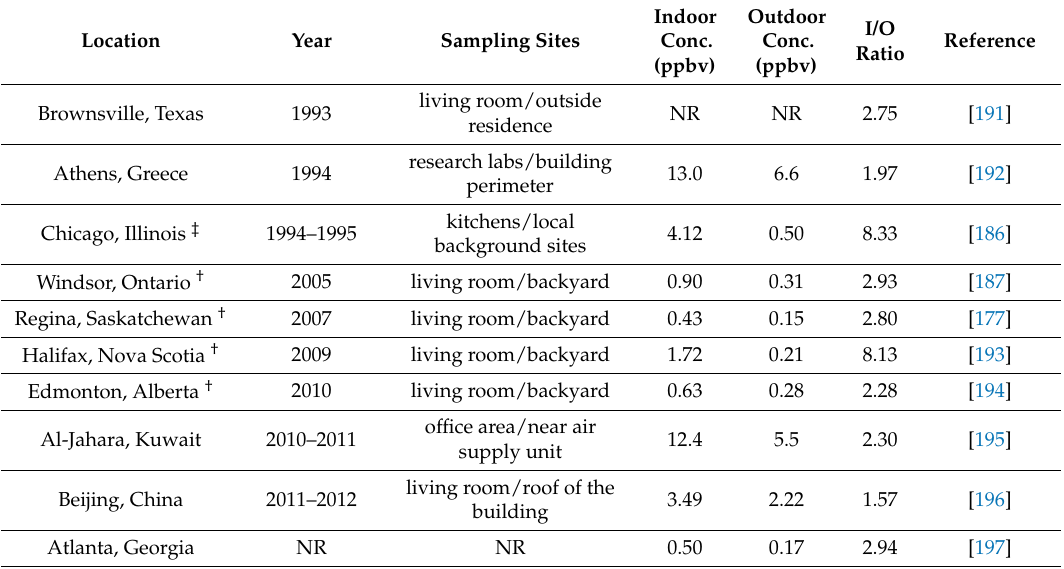
Table 4. Comparison of the indoor/outdoor ratios of ETH from various studies *. Location Year Sampling Sites